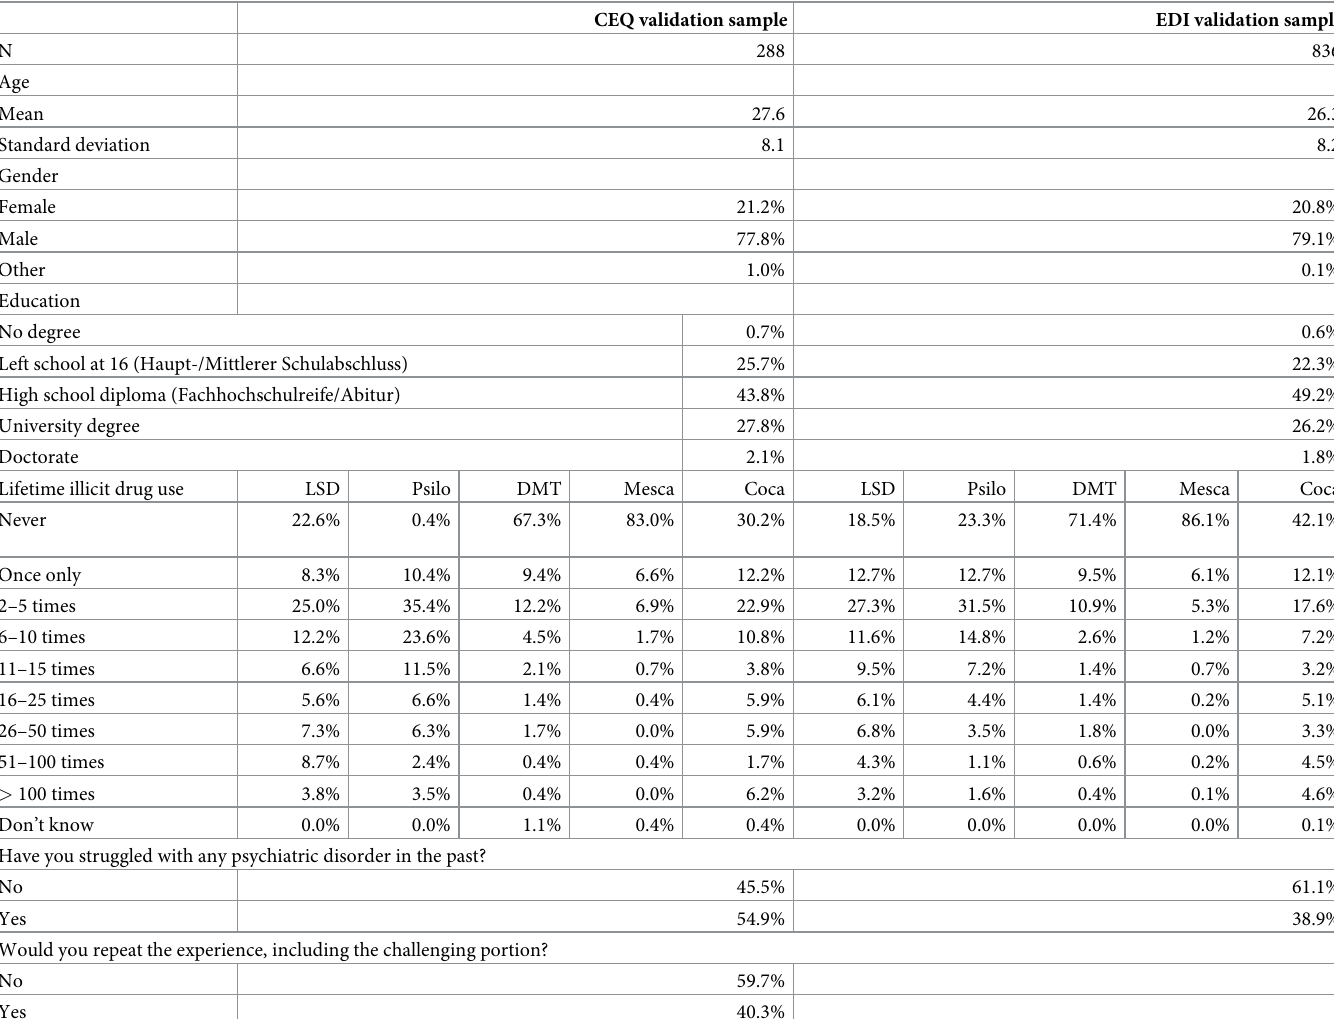
Table 1. Sample characteristics for the CEQ and EDI validation